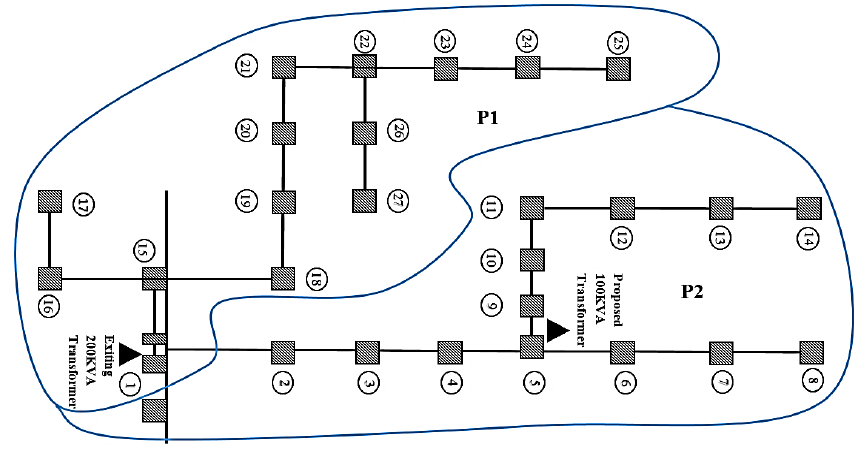
Fig. 6. Sketch showing existing LT line at Lakher Abad, university town Peshawar